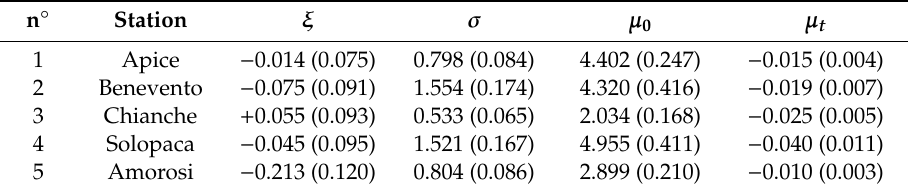
Table 2. Nonstationary GEV probability models parameters estimated using the Maximum Likelihood Estimator (MLE). Standard error of estimated parameters is reported in parentheses.